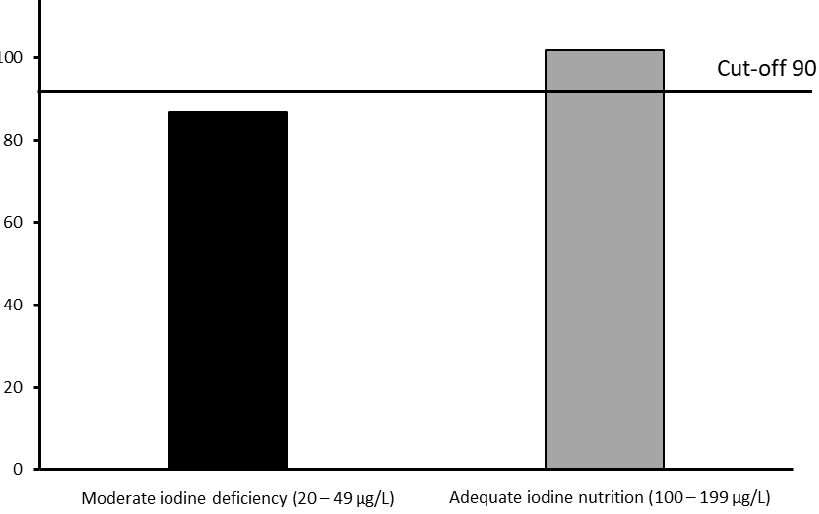
Figure 4. Wechsler Intelligence Scale for Children—Third Edition (WISC-III) Full-Scale IQ (mean) according to iodine status: Moderate Iodine Deficiency (UIC 20–49 µ g/L, n = 30) vs. Adequate Iodine Intake (UIC 100199 µ g/L, n = 30) subgroups.